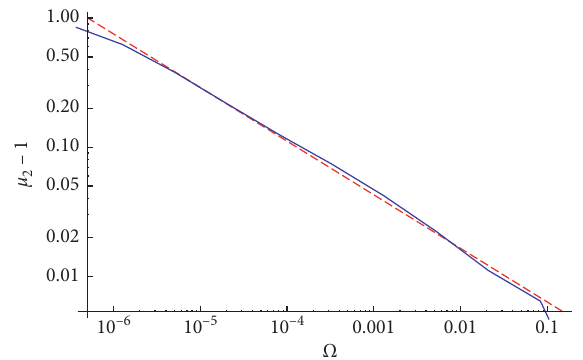
Figure 4: Values of μ ( Ω ) − 1 after shot noise suppression, for the 2 distributions of stellar mass, with linear fit (dashed line). It gives c � 1 .